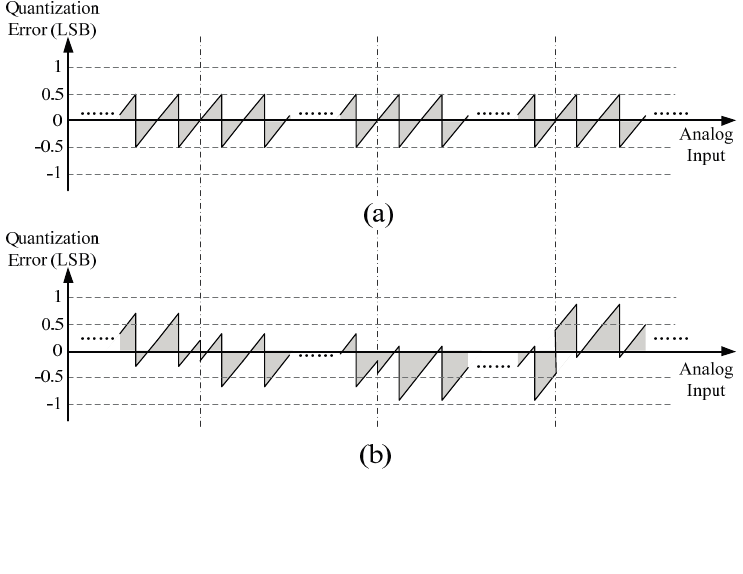
Figure 6. ( a ) The ideal curve of quantization error e col versus input voltage; ( b ) Different parts of the curve have a uncertain shift because of e cali, k